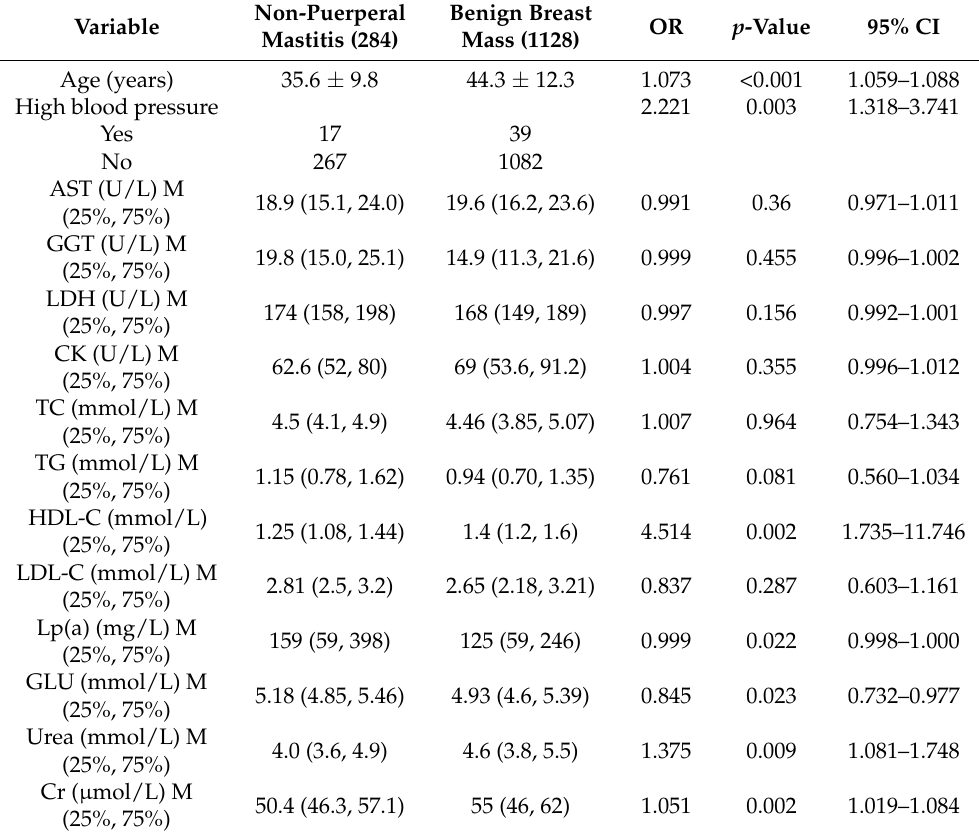
Table 2. Univariate logistic regression analysis of selected risk factors between non-puerperal mastitis and benign breast mass.